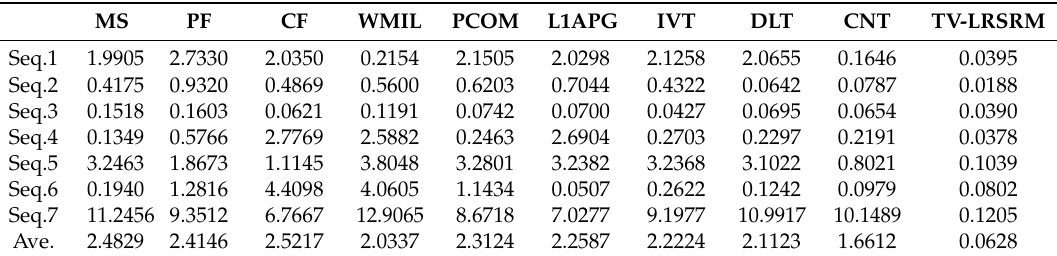
Table 2. Average normal center location errors ε 0